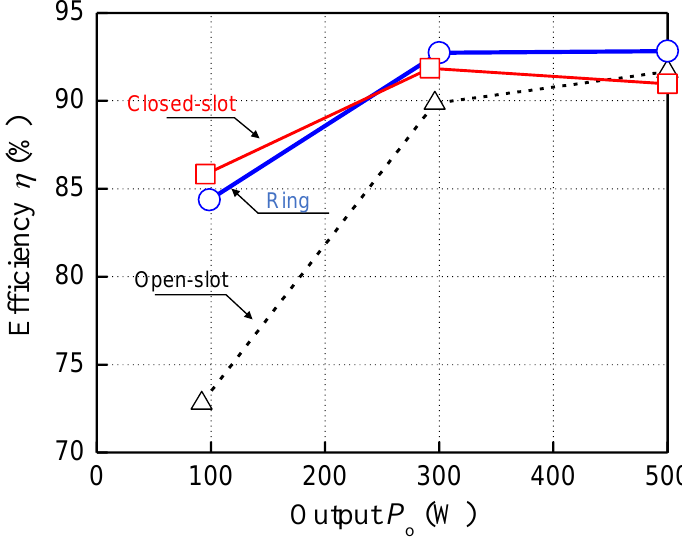
Figure 10. Dependence of the motor efficiency on the output.